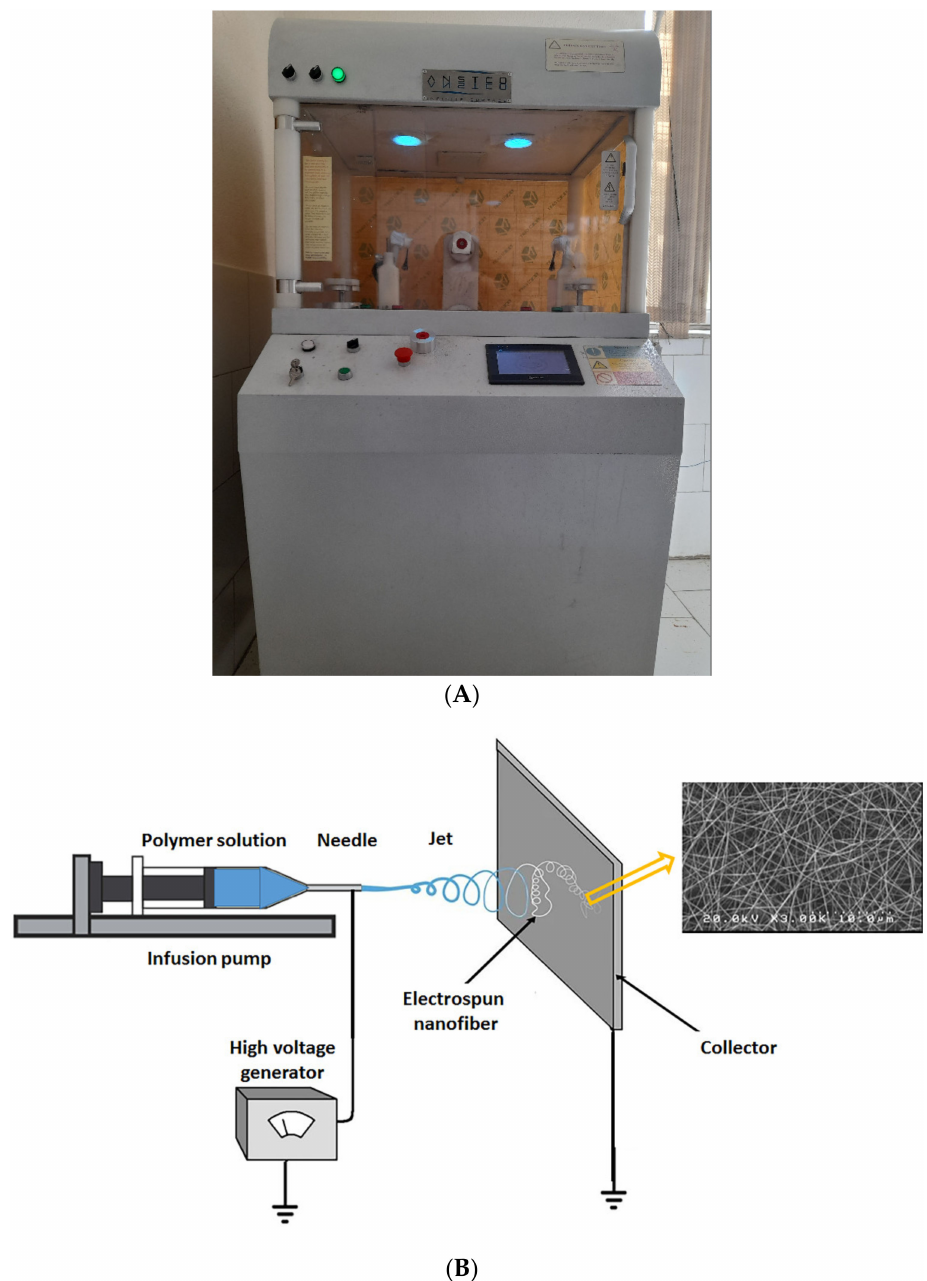
Figure 1. The electrospinning machine ( A ) and the schematic of electrospinning setup ( B